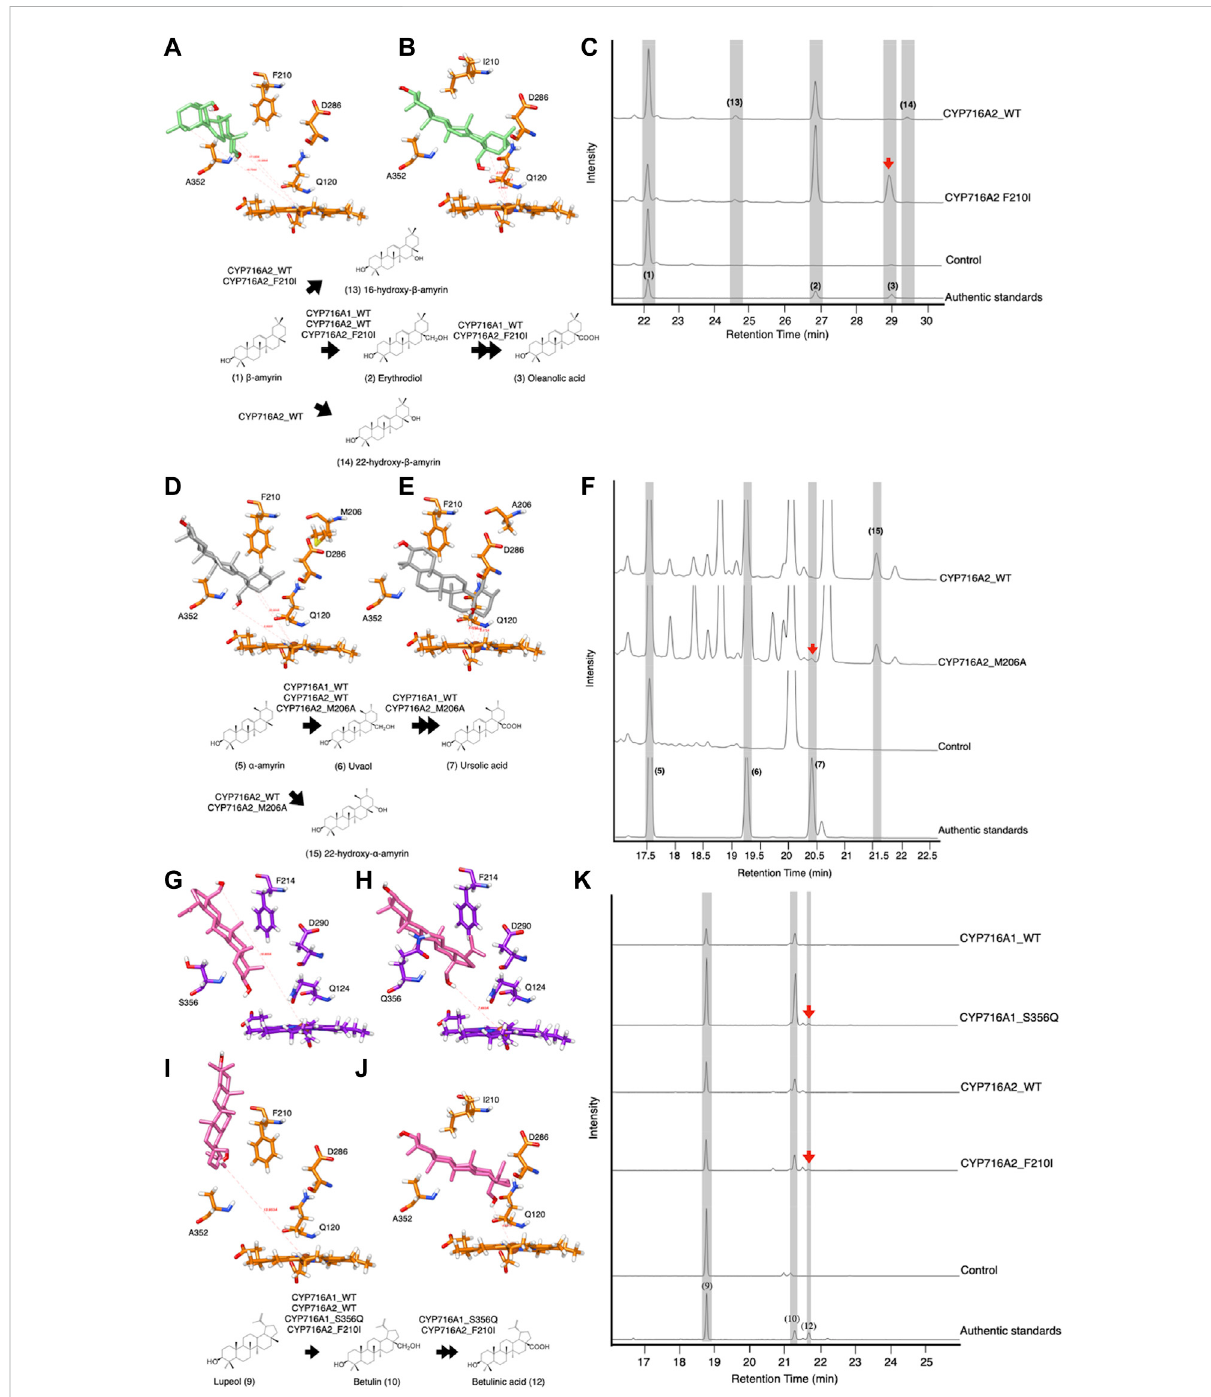
FIGURE 5 In-silico study and In vivo activity of CYP716A1 and CYP716A2 toward triterpene skeletons in co-expressing yeast strain. Representative interactions of (A) CYP716A2 wild-type, and (B) it variant (CYP716A2_F210I) against erythrodiol backbone. (C) TICs of extracts from yeast harboring one bAS expression vector for producing β -amyrin and three CYPs expression vectors of CYP716A2 or its variant (CYP716A2_F210I). Representative interactions of (D) CYP716A2 wild-type, and (E) it variant (CYP716A2_M206A) against uvaol backbone. (F) TICs of extracts from yeast harboring aAS expression vector for producing α -amyrin as a major substrate and three CYPs expression vectors CYP716A2 or its variant (CYP716A2_M206A). Representative interactions of (G) CYP716A2 wild-type, and (H) it variant (CYP716A2_M206A) (I) CYP716A1 wild-type, and (J) it variant (CYP716A1_S356Q) against betulin backbone. (K) EIC of extracts from yeast harboring one LUS expression vector for producing lupeol and three CYPs expression vectors of CYP716A2 or CYP716A2_M206A or CYP716A1 or CYP716A1_S356Q. Data are representative of at least three biological replicates ( n =